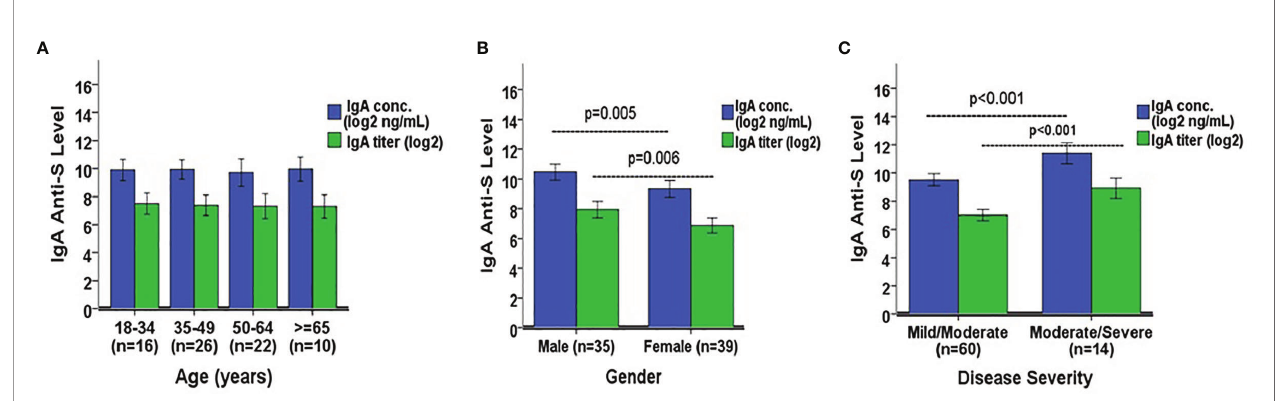
FIGURE 6 | Comparison of IgA anti-S geometric mean levels by (A) age, (B) gender, and (C) disease severity. A one-way ANOVA was used for the statistical analysis of mean differences between age comparison, and an independent Student ’ s t test was employed for mean differences in gender and disease severity. A total of 74 SARS-CoV-2 PCR positive sera were analyzed in the comparison. Error bars represent standard